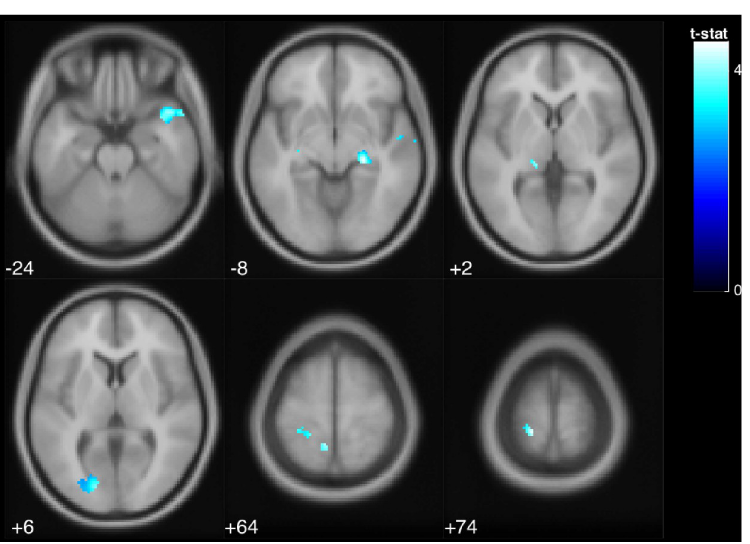
Fig 8. The deactivation of postcentral gyrus, intracalcarine cortex, and temporal pole was positively correlated with age and balance performance in normal stance (indicated by area of ellipse). The colored voxels show the regions of the brain in which the BOLD signal was significantly decreased from rest to stimulation in a way that correlated with age across subjects. The shade of the color in each brain map corresponds to the t-value in the legend bar.